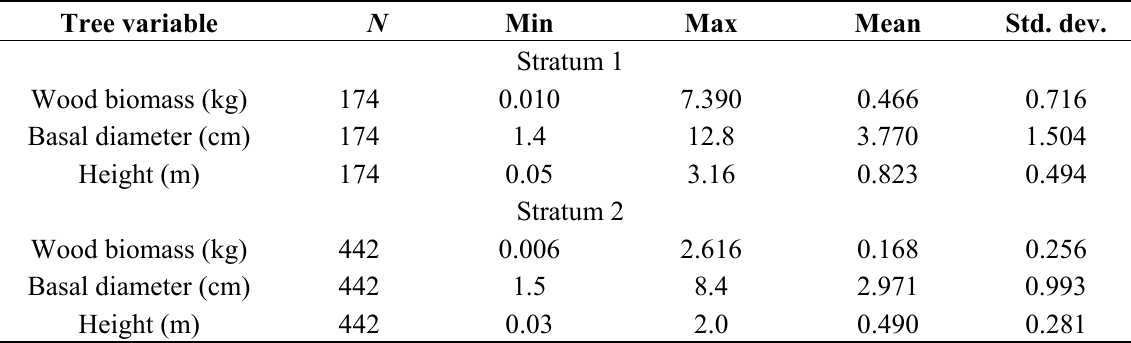
Table 2. Description of the final